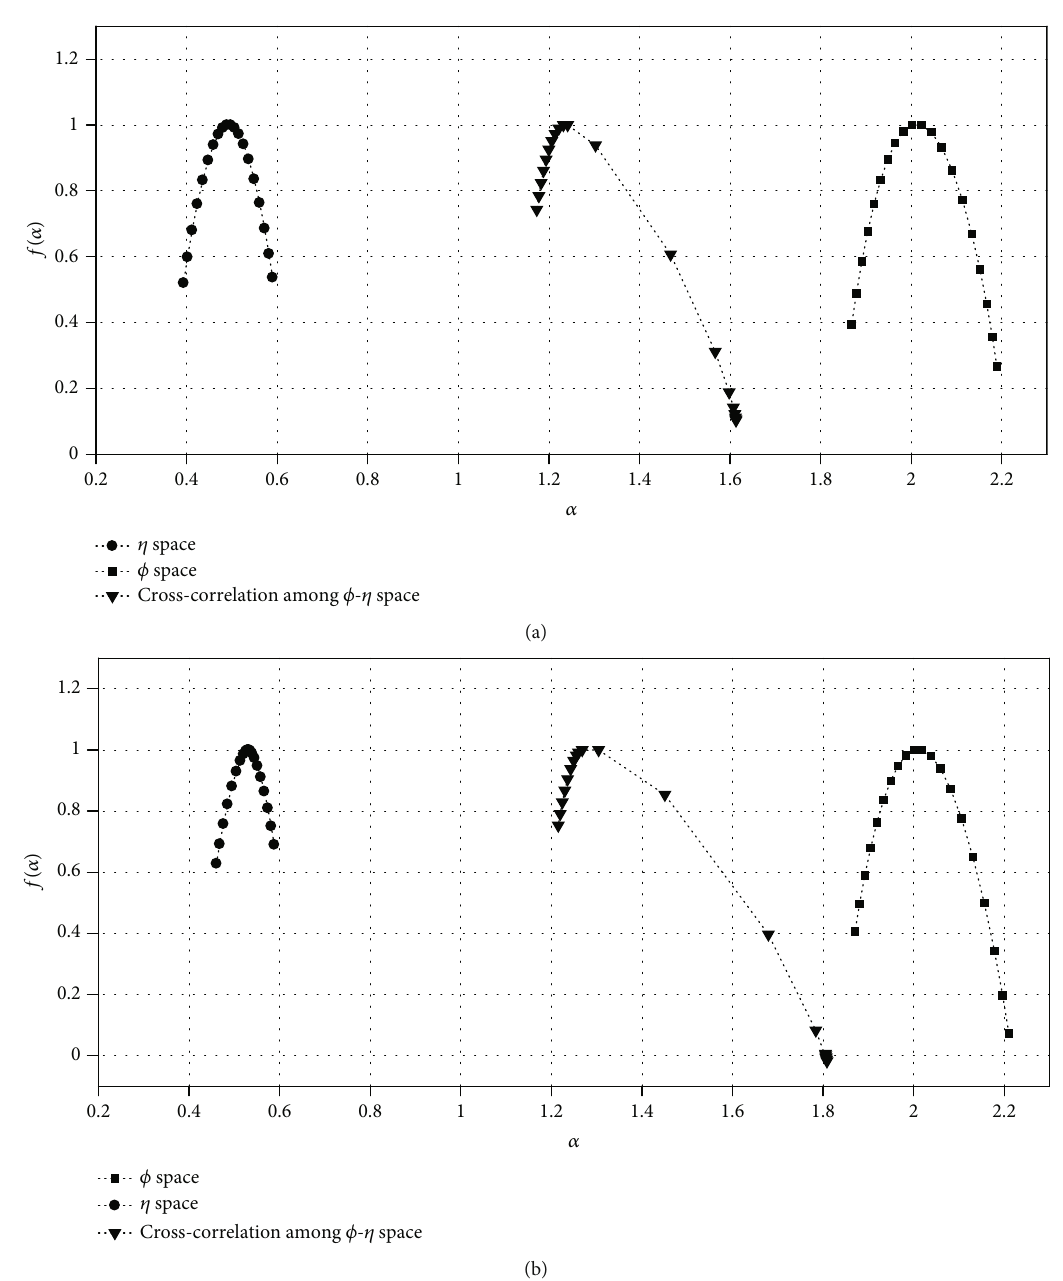
Figure 6: Comparison of the trend of di ff erent values of f ð α Þ versus α among the same η , ϕ spaces and the same trend calculated for their cross-correlation, for the (a) 8TeV dataset and (b) 7 TeV